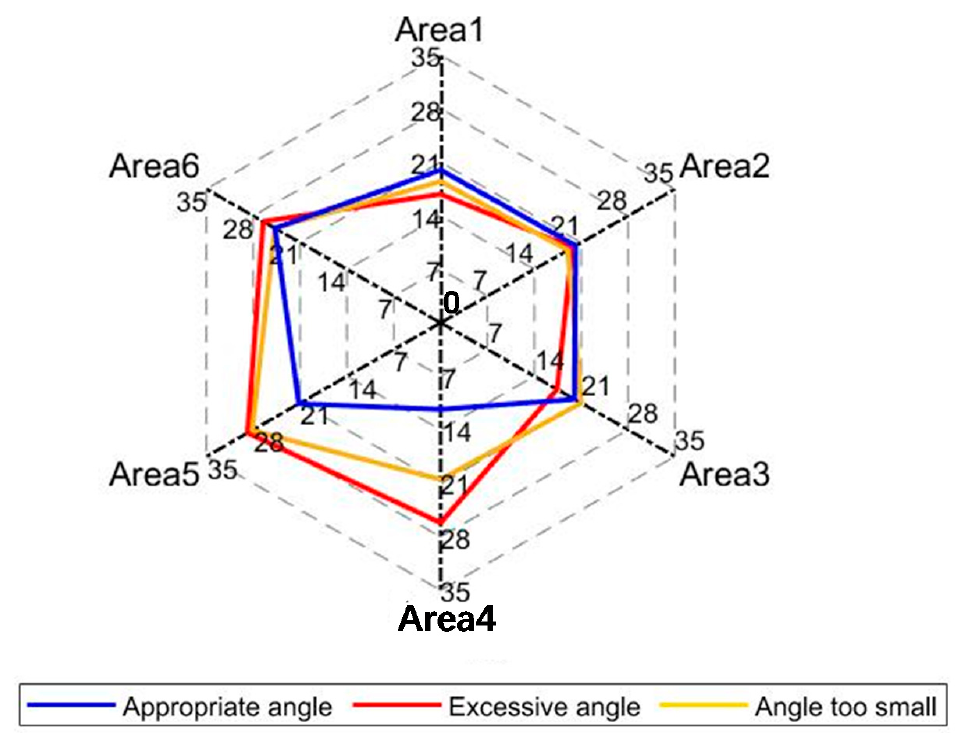
Figure 10. The average degree of the six areas is analyzed. The value change in the radar chart from inside to outside indicates the change of average degree value. The smaller value is near the center, and the greater value is near the outside. Six corners represent six areas. The blue line represents the appropriate angle, the red line represents the excessive angle, and the yellow line represents the angle too small.